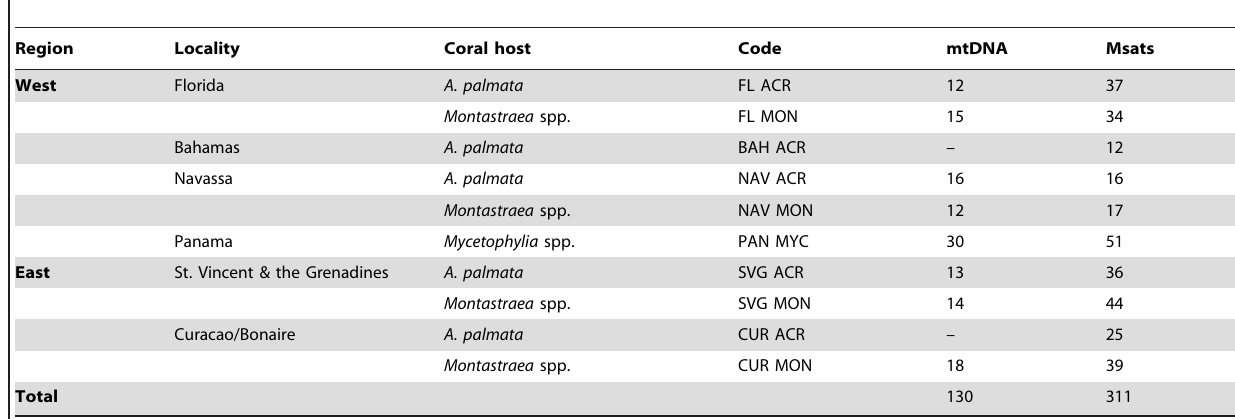
Table 1. Sample sizes of Coralliophila abbreviata by coral host and locality for mitochondrial cytochrome b sequences (mtDNA) and microsatellite markers